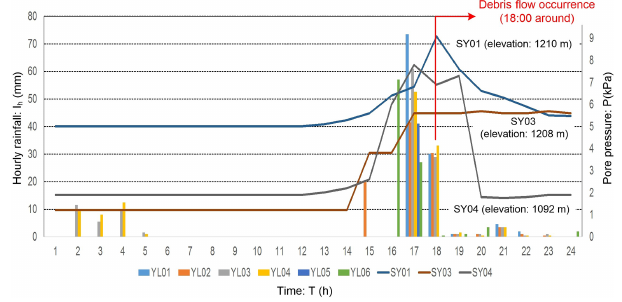
Figure 8. The rainfall and pore pressure in Wenjia gully on 14 Au- gust 2012 (the column graphs are hourly rainfall and the single line curves are pore pressure).